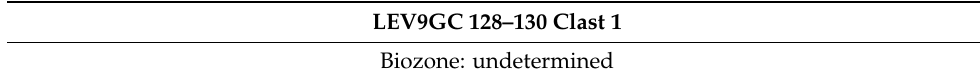
Table A45. Leipzig